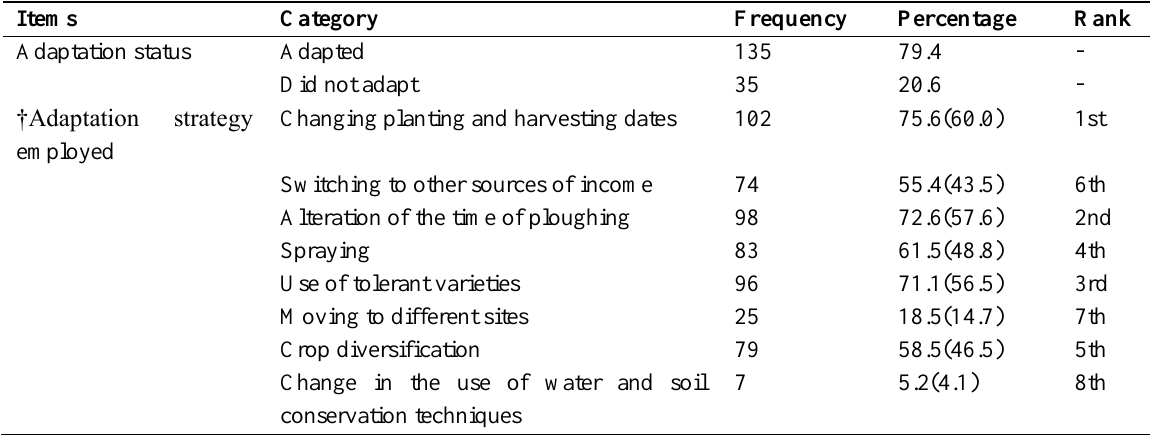
Table 5: Adaptation status and strategies applied by